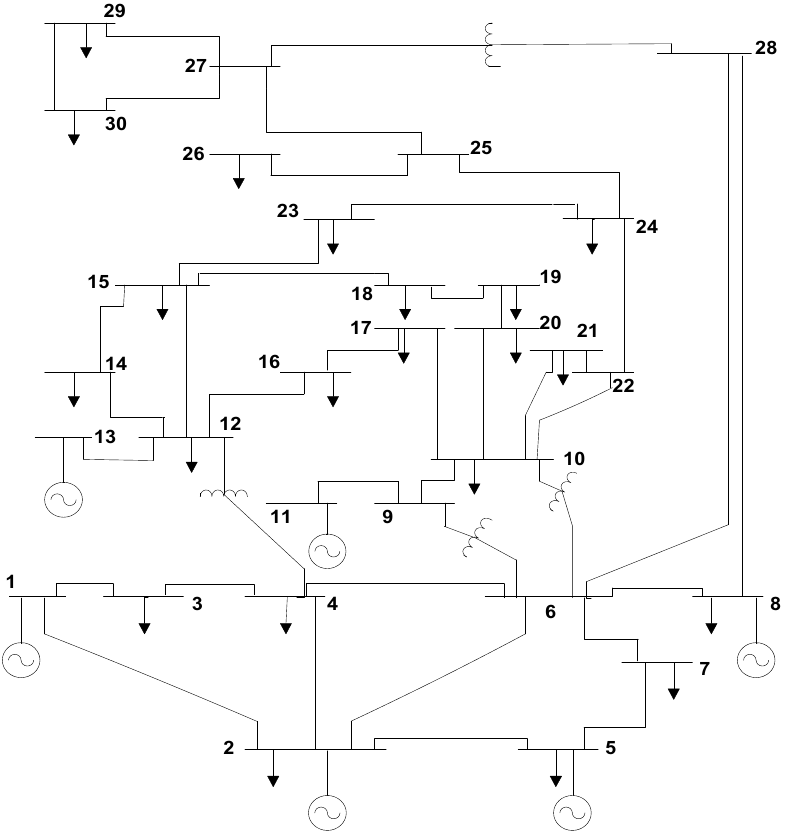
Figure 4. Single line diagram of the IEEE 30-bus test system.